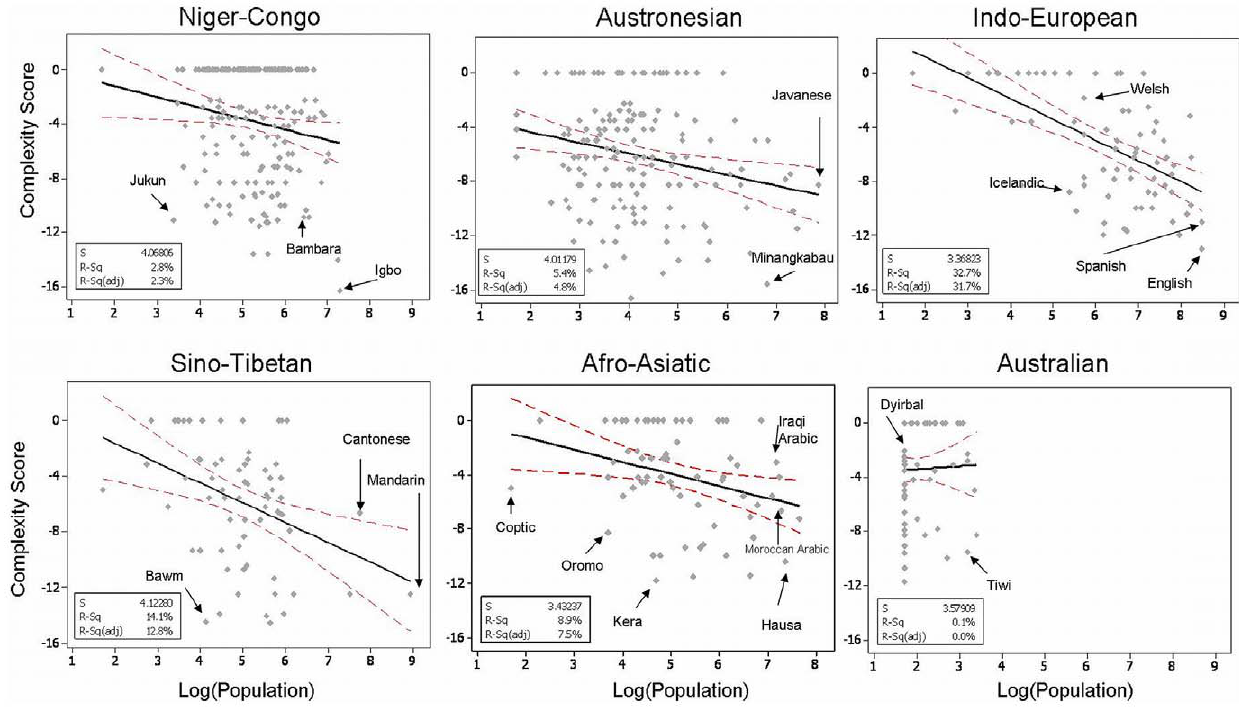
Figure 5. The relationship between population and morphological complexity for the 6 largest language families in our sample. Interestingly, a number of the languages that lie far below the regression line are lingua francas, e.g., Hausa, Bambara, and Oromo are all used as lingua francas (vehicular languages). The Padang dialect of Minangkabau (the second simplest Austronesian language by our measure) is also a lingua franca around West Sumatra,